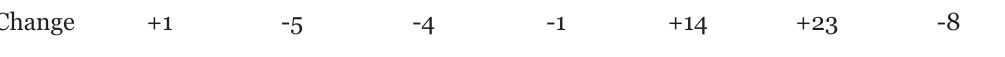
Change in CRT Scores for Teachers Using Open Textbooks 2010–2011